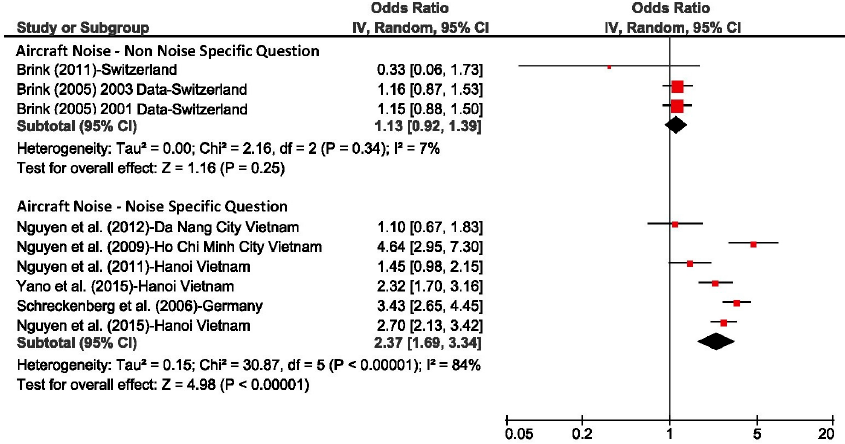
Figure 10. Meta-analysis on the effects of aircraft noise on self-reported sleep disturbance (combined estimate) based on Odds Ratios for a 10 dBA increase in L night level for aircraft noise. The number of studies and subjects contributing to the analyses can be found in Table 2.